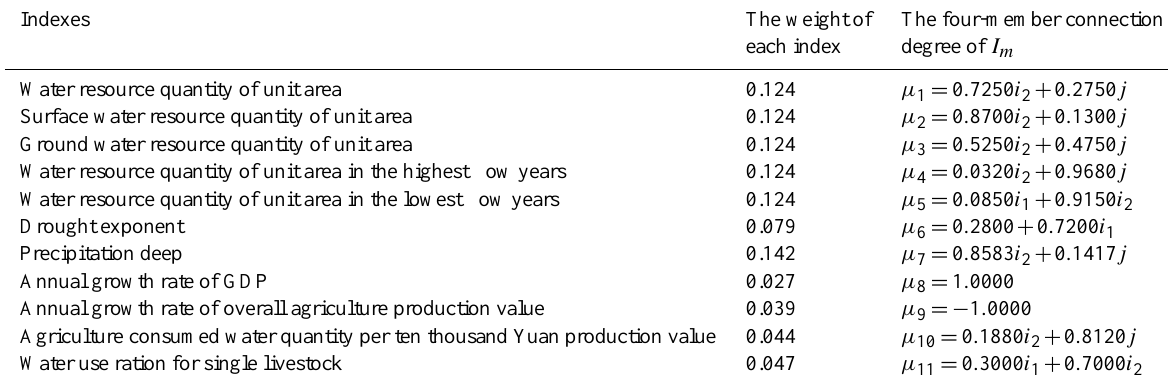
Table 5. The four-member connection degree of I m of Qinghai province.